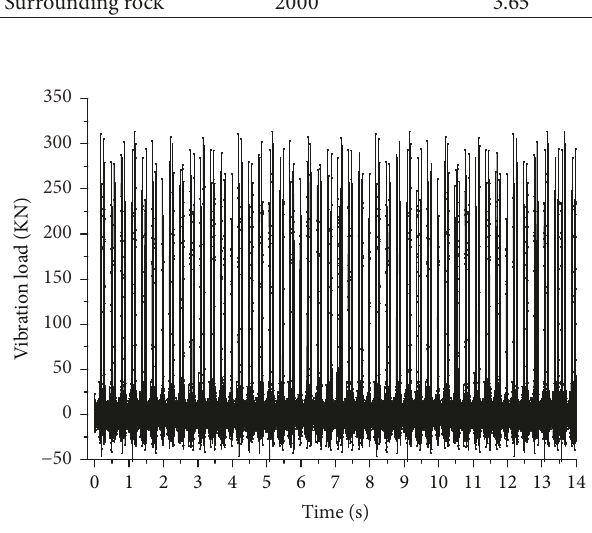
Figure 6: Measured train vibration load curve (300km/h).